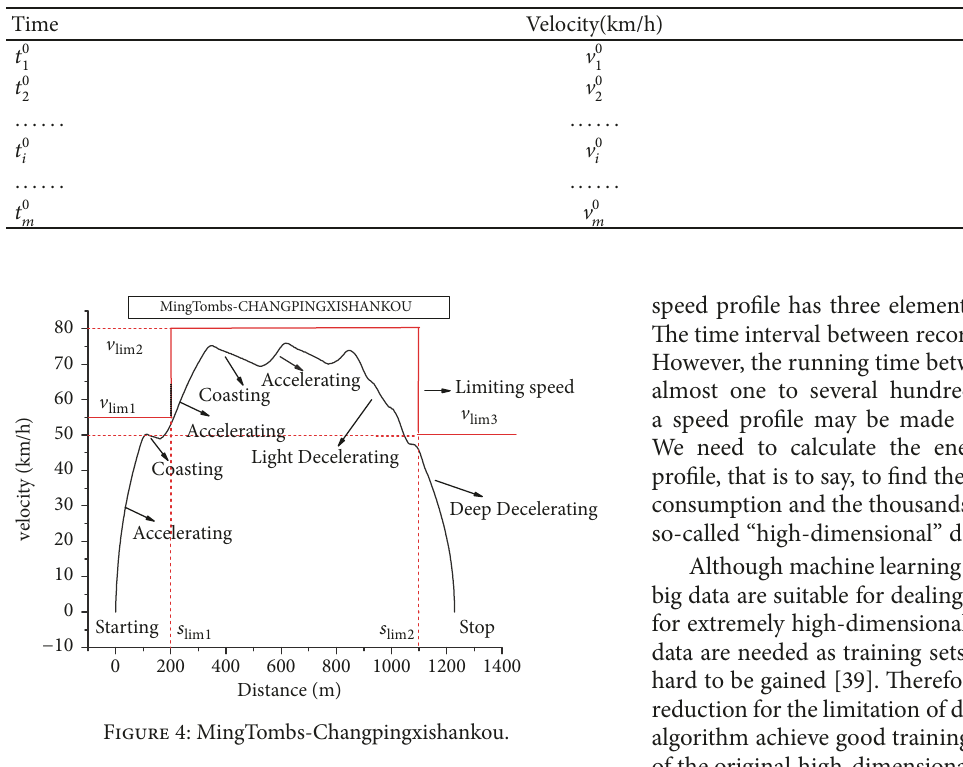
Table 3: Part types of the original data.